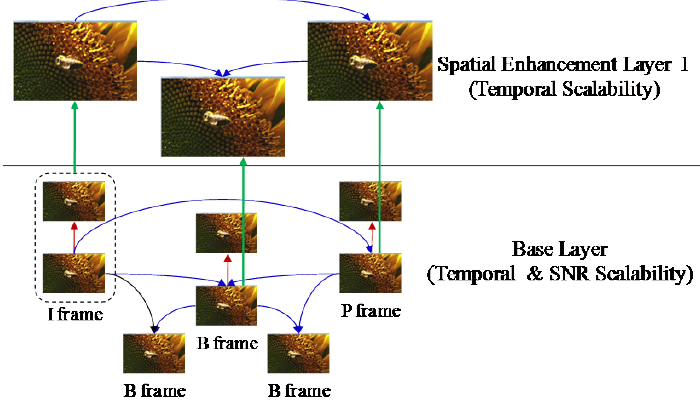
Figure 2. The layered feature of H.264 SVC.